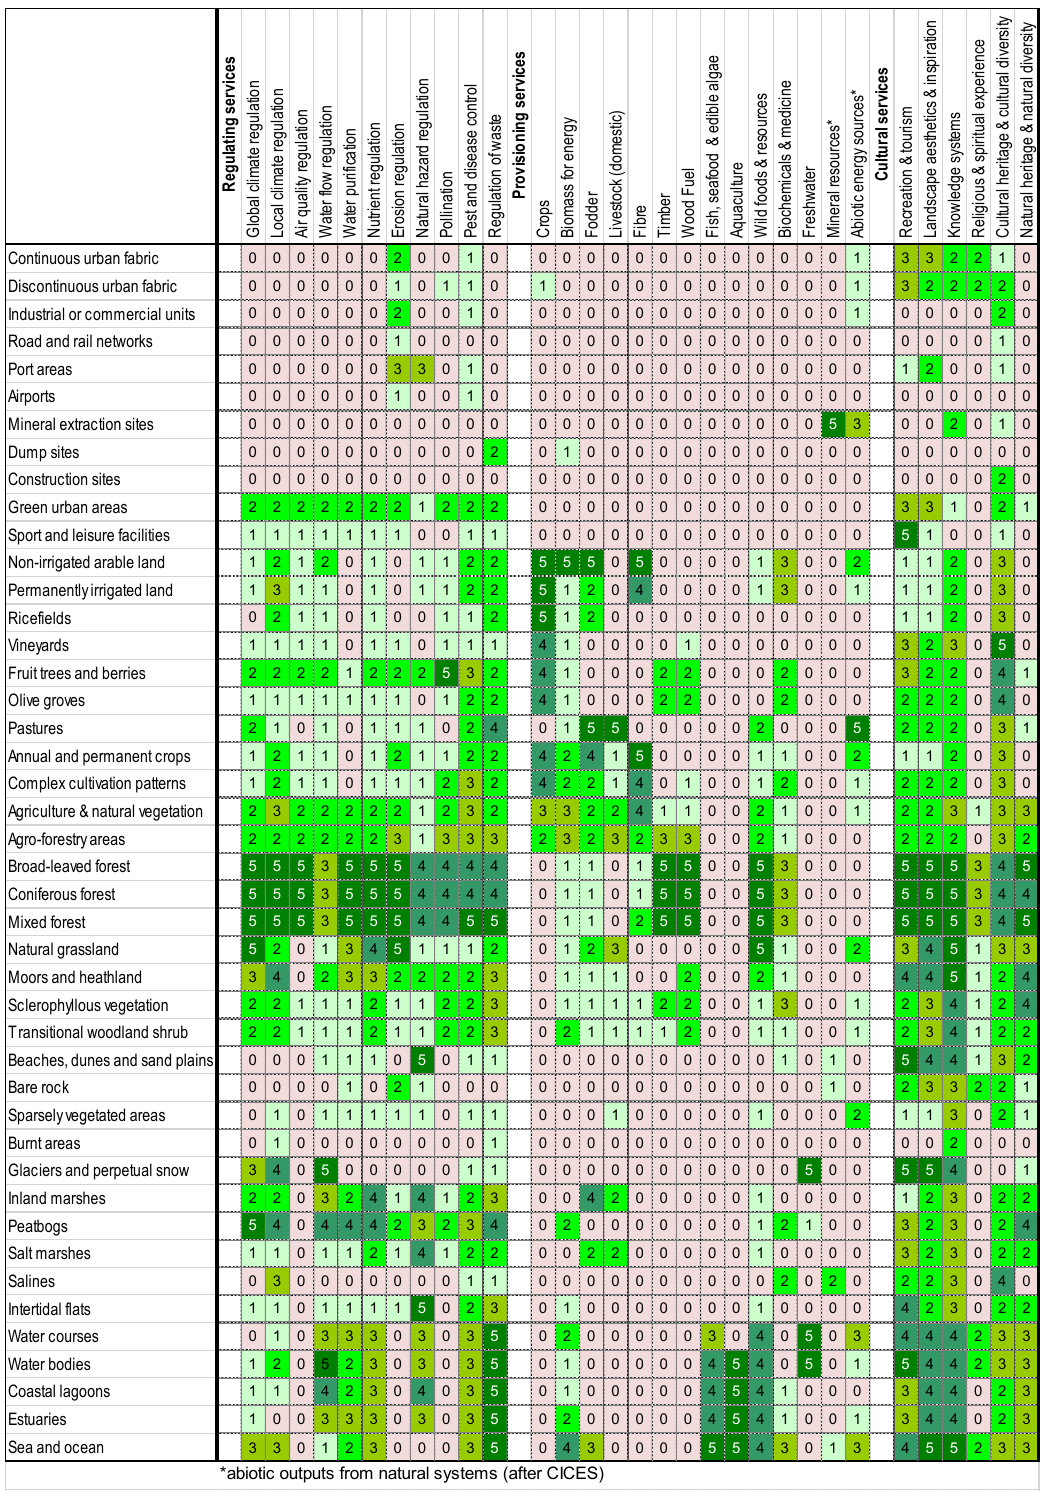
Figure 4: Exemplary ecosystem service potential matrix. The exemplary evaluation refers to a hypothetical European „normal“ landscape in summer (before the harvest period). Scale from 0/rosy = no relevant potential; 1/grey green = low relevant potential; 2/light green = relevant potential; 3/yellow green = medium relevant potential; 4/blue green = high relevant potential; and 5/dark green = very high (maximum) relevant potential (after Burkhard et al. 2009 and